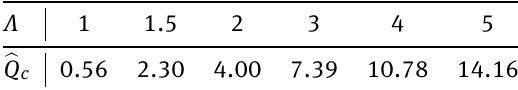
Table 2: The dimensionless discharge ̂︀ Q c calculated for the point where the pumpablity contribution is the same for the plastic viscos- ity as for the thixotropically grown yield stress. This interpretation may be useful as a design point for the pumping application.